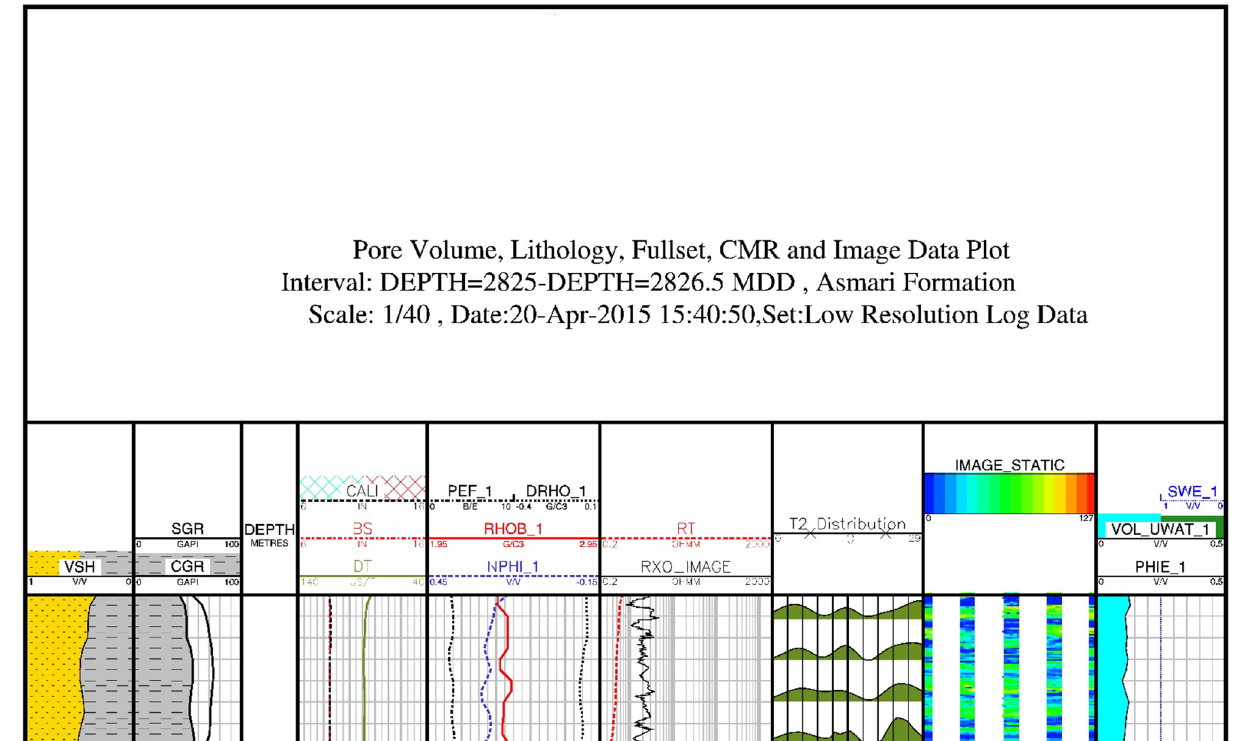
Fig. 12 Conventional logs